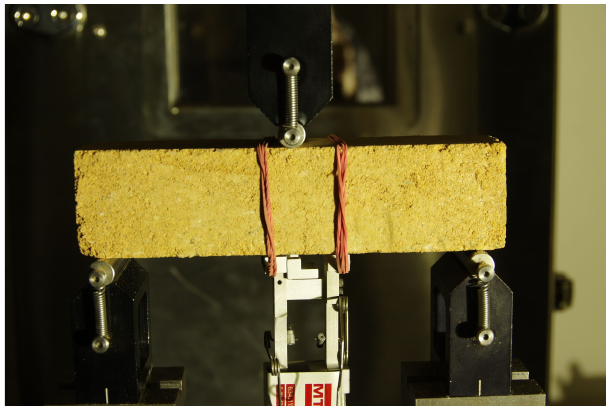
Figure 4. The three-point bending test on specimen from rammed earth material.